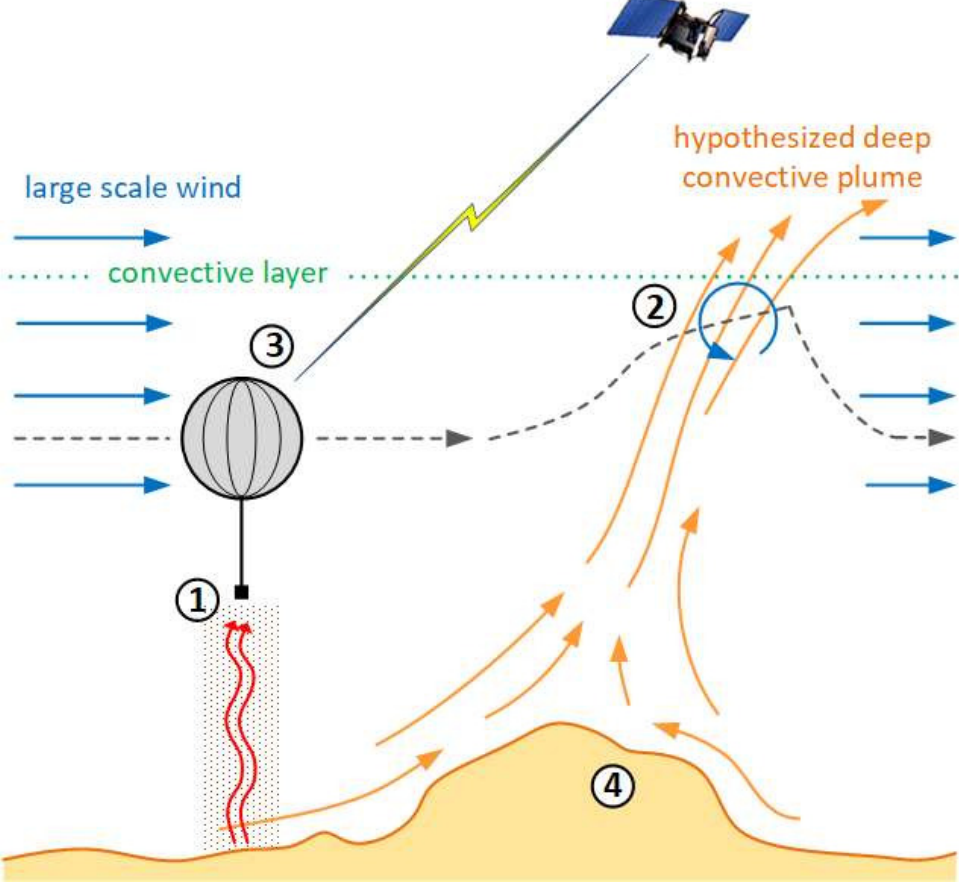
Figure 1. Illustration of the scientific concept of operations for a balloon-probe drifting within the planetary boundary layer: measuring heat flux (1), vertical (2) and horizontal wind speed (3), and registration of observations to topographic features (4).